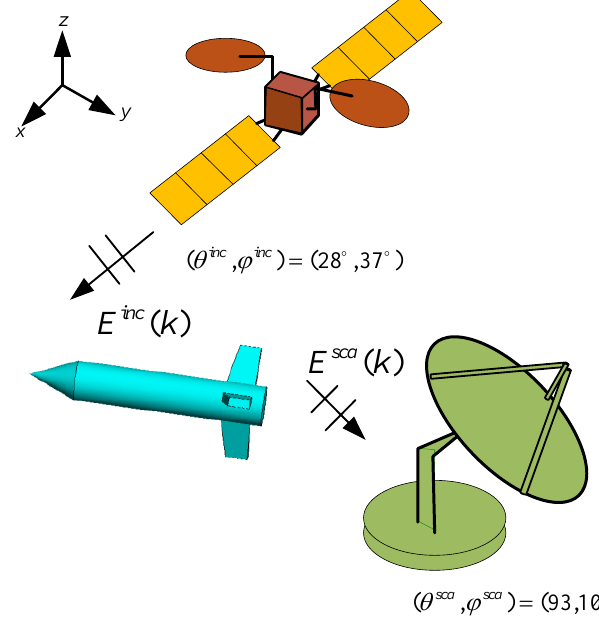
Figure 13. The posture of the coated missile based on satellite-borne illuminator.